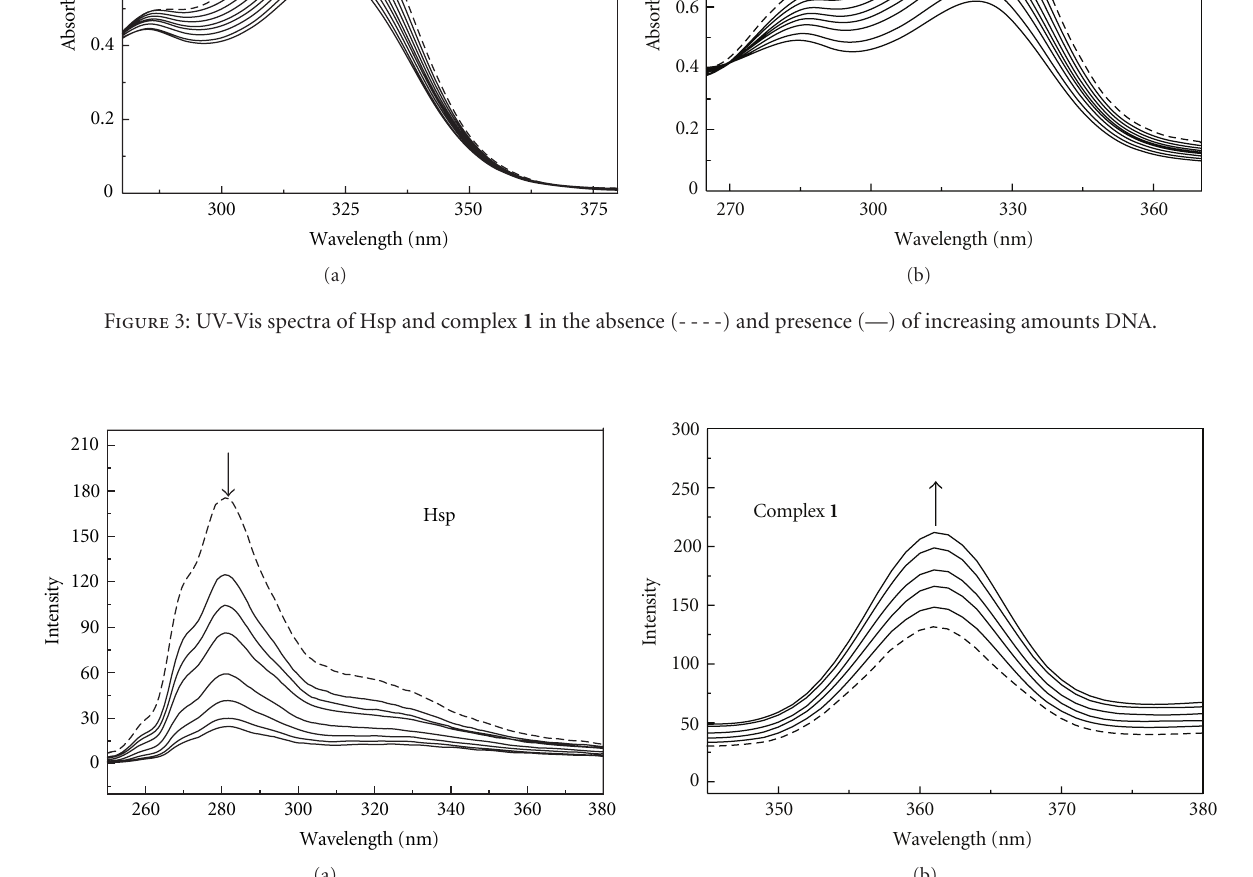
maintaining the B conformation in solution. The